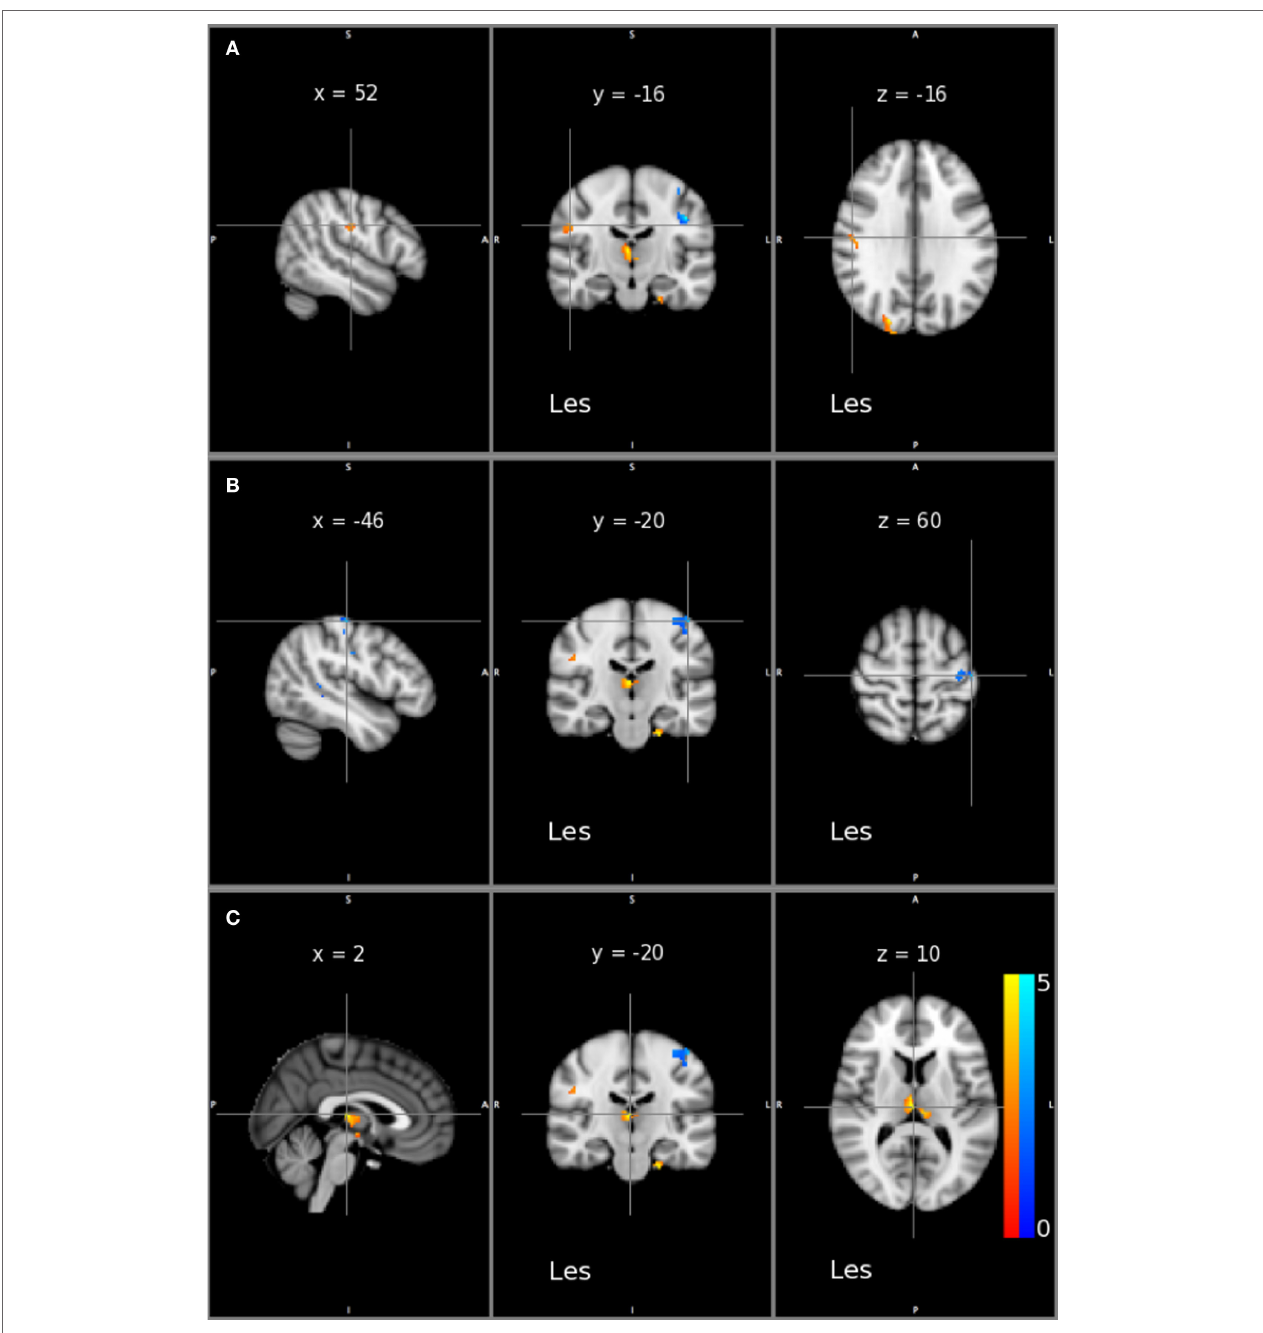
FigUre 5 | Statistical maps of gray matter (GM) density changes across all patients. Significant increases (red/yellow) and decreases (Blue) in GM density are depicted on sagittal, coronal, and axial sections (left to right) on Montreal Neurological Institute T1 slices. Sections show the maximum effect on (a) ipsilesioned M1/S1, (B) contralesional M1/S1, and (c) ipsilesional thalamus. Les indicates the side of the lesioned hemisphere. Color maps indicate the t values at every voxel. A statistical threshold was set at p < 0.001